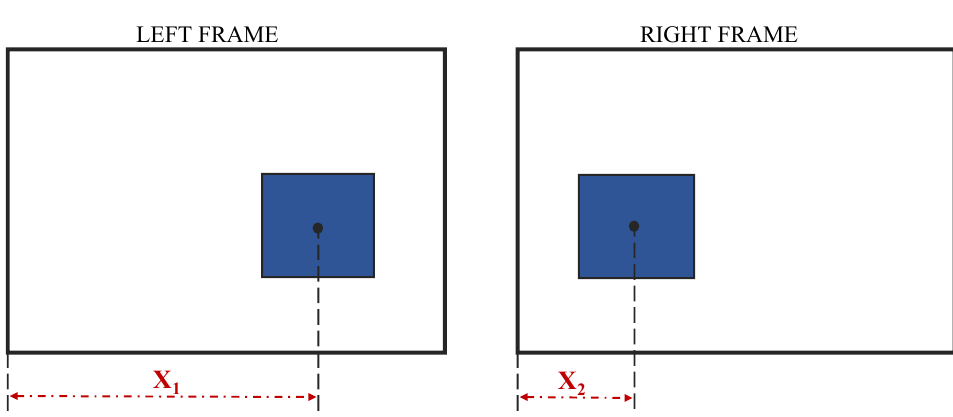
Figure 5. Scheme of the disparity